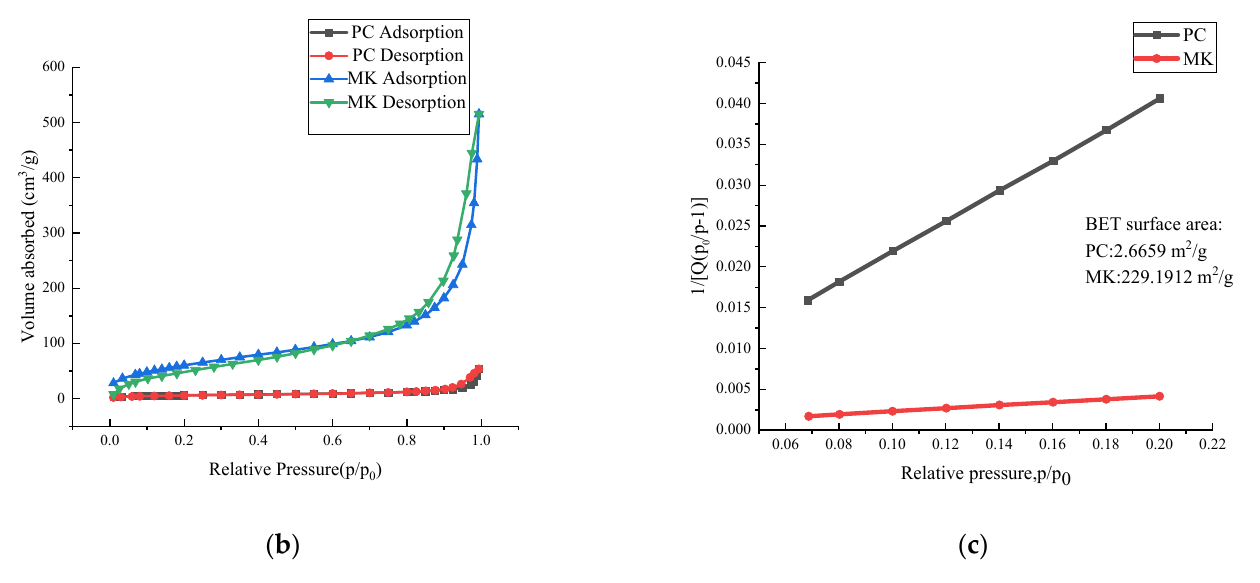
Figure 1. Physical properties of PC and MK. ( a ) Particle size distribution of PC and MK, ( b , c ) Nitrogen isotherms of PC and MK.